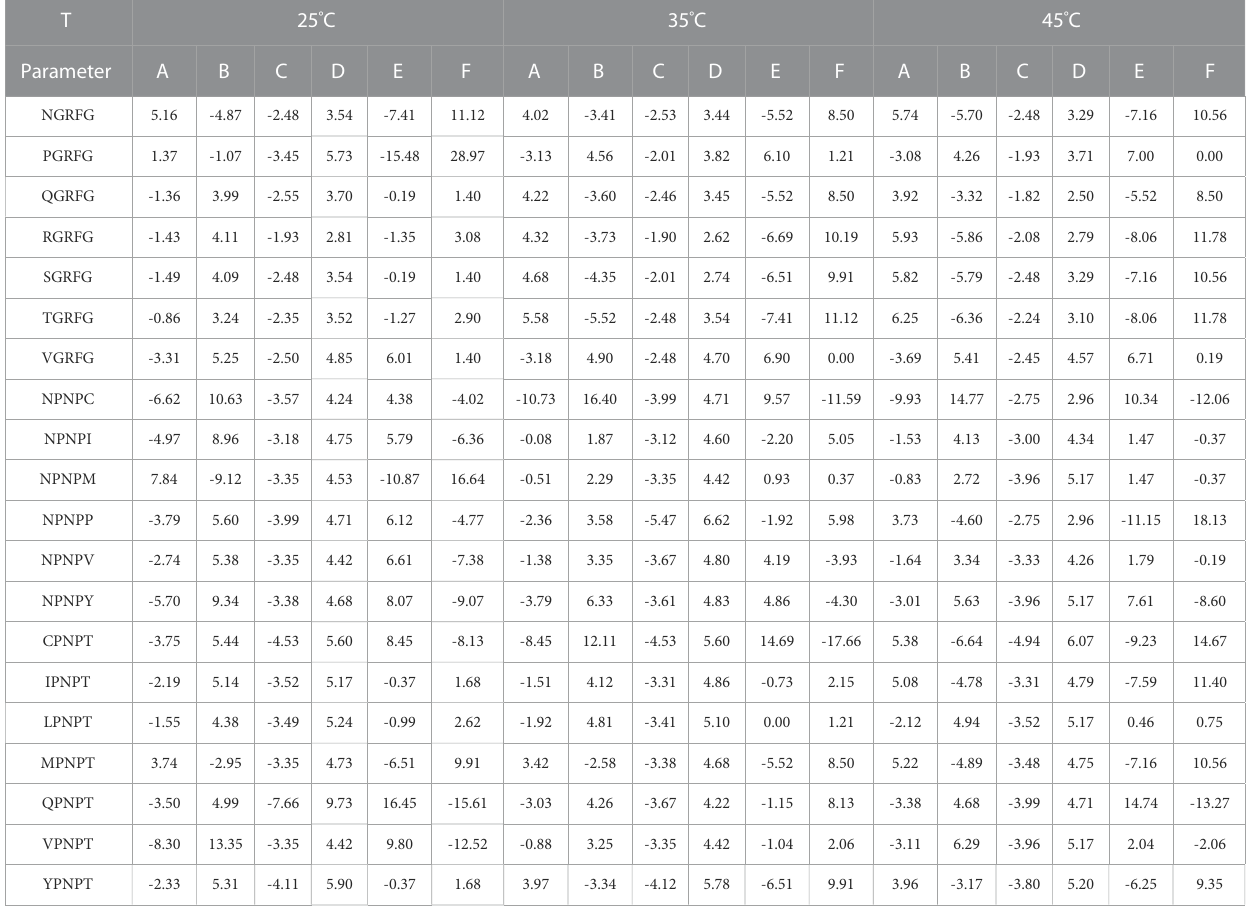
TABLE 7 ( Continued ) Parameter results of fi tting with P N m and pH at different temperatures.